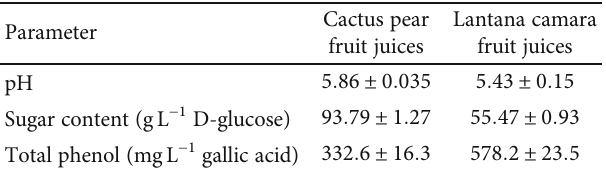
Table 1: Physicochemical characteristics of fresh cactus pear and Lantana camara fruit juices.